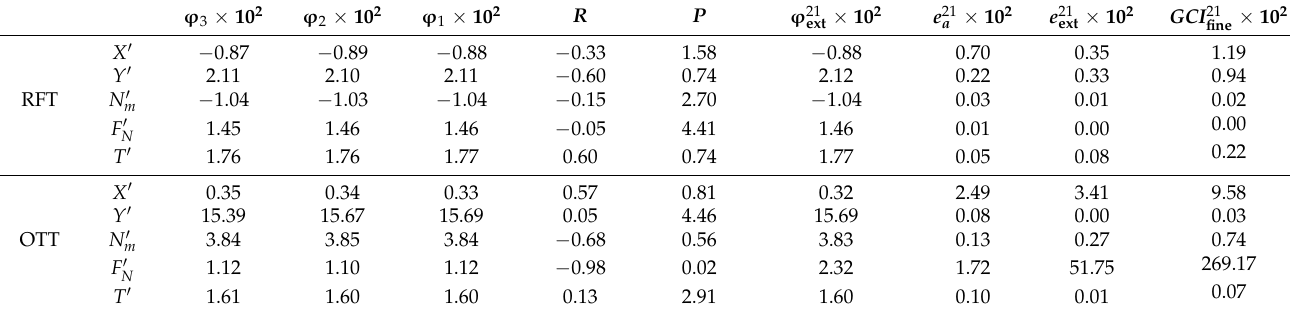
Table 3. The discretization error and uncertainty in temporal convergence study (MRF method).